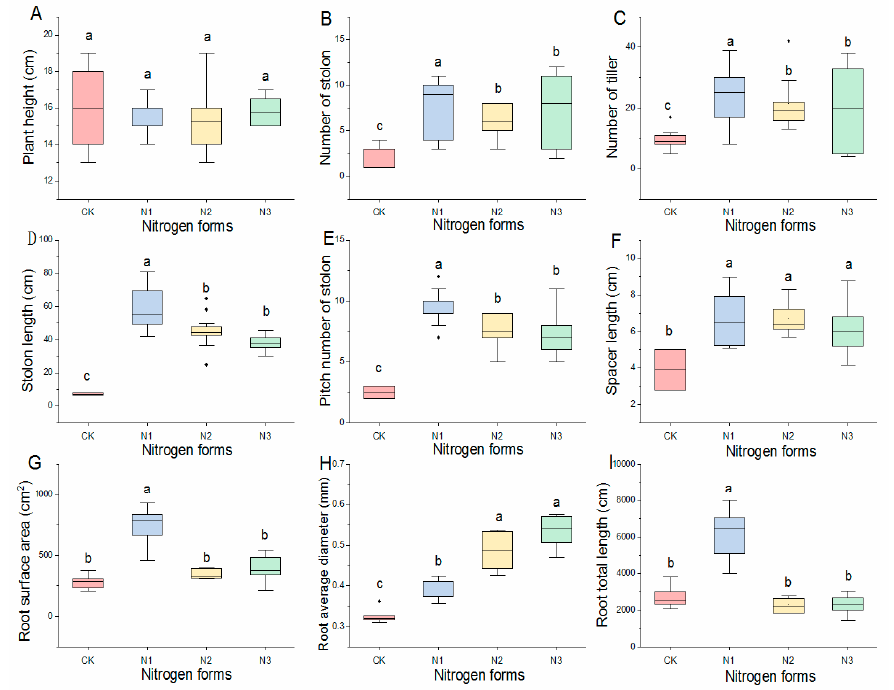
Figure 1. Box plot of growth characters of buffalograss seedlings, as affected by nitrate, ammonium, and ammonium nitrate. Each value is the mean ± SD ( n = 10). The values not sharing the same letters are significantly different at p < 0.05 according to Duncan’s test of one-way ANOVA. CK, -NH 4 NO 3 ; N1, +NO 3 − ; N2, +NH 4+ ; N3, +NH 4 NO 3 . Box plots indicate interquartile range in the box area, median (solid line in the box), mean (solid circle in the box) 25% and 75% percentiles (lower and upper box margins), 10% and 90% percentiles (lower and upper error bars), and outliers (solid rhombus outside the error bars). Note: ( A ): plant height of buffalograss seedlings in different nitrogen forms. ( B ): stolon number of buffalograss seedlings in different nitrogen forms. ( C ): tiller number of buffalograss seedlings in different nitrogen forms. ( D ): stolon length of buffalograss seedlings in different nitrogen forms. ( E ): pitch number of stolon of buffalograss seedlings in different nitrogen forms. ( F ): spacer length of buffalograss seedlings in different nitrogen forms. ( G ): root surface of buffalograss seedlings in different nitrogen forms. ( H ): root average diameterof buffalograss seedlings in different nitrogen forms. ( I ): root total length of buffalograss seedlings in different nitrogen forms.